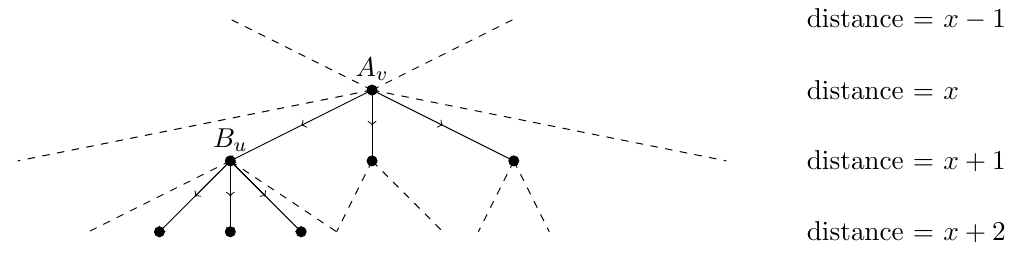
Figure 16 . If qudit q ( v ) is at distance x from the centre of the HQECC, and qudit q ( u ) is a neighbouring qudit at distance x + 1 from the centre, then an operator A v acting on q ( v ) can be pushed through q ( u ) , so pushing an operator A v (cid:10) B u where B u acts on q ( u ) through the tensor network will lead to a boundary operator with the same weight as pushing A v alone through the tensor